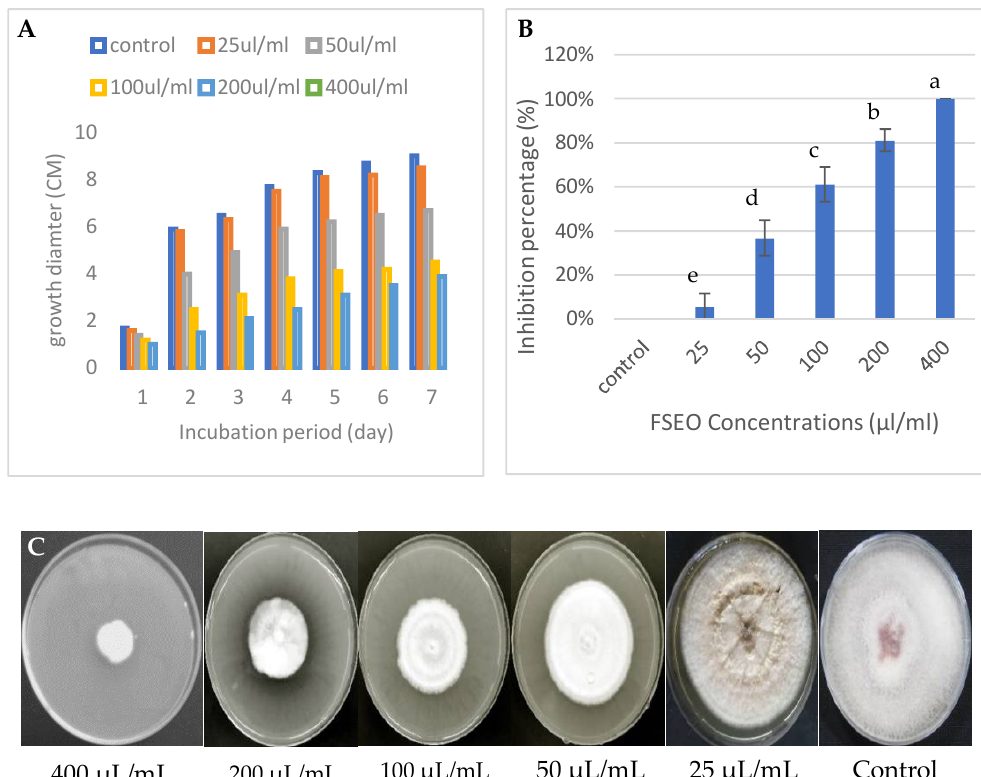
Figure 3. Effect of FSEO on F. solani ( A – C ): ( A ) radial growth at different incubation periods from 1 to 7 days; ( B ) inhibition percentages of F. solani at different concentrations of FSEO; ( C ) radial growth on Czapek-Dox agar medium (CZA) plates at 7 days. CZA not supplemented with FSEO was used as a control. Data are expressed as means ± standard deviations of triplicate assays. Different alphabetic superscripts in the same column are significantly different ( p < 0.05) based on Tukey’s multiple comparison test. Table 3. Mean Fusarium root rot incidence and severity at pre- and post-emergence damping off after different treatments were applied to Vicia faba L.